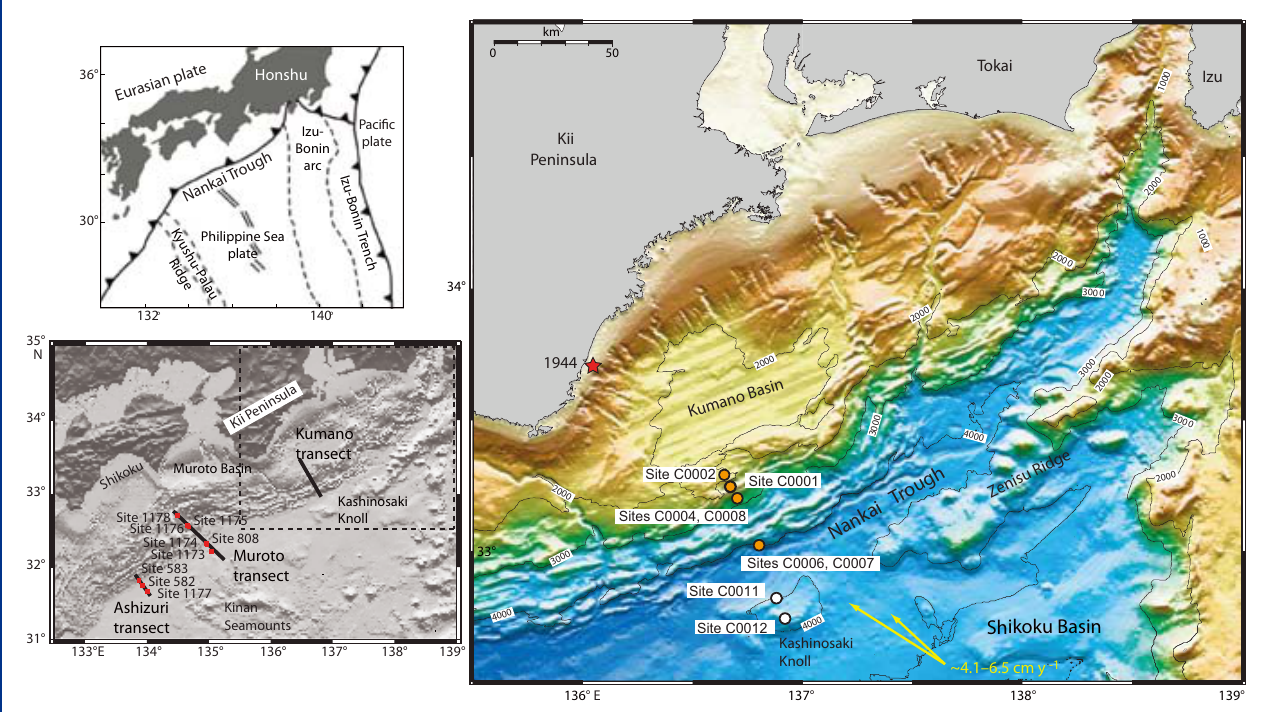
Figure 1. Maps of Nankai Trough and Shikoku Basin showing locations of previous DSDP and ODP drill sites (Ashizuri and Muroto transects), Kumano transect area, Stage 1 NanTroSEIZE coring sites (C0001, C0002, C0004, C0006, C0007, C0008), and Expedition 322 drill sites (C0011 and C0012). Yellow arrows show convergence vector between Philippine Sea plate and Japanese Islands (Eurasian plate). Red star gives epicenter for nucleation of large subduction earthquake in